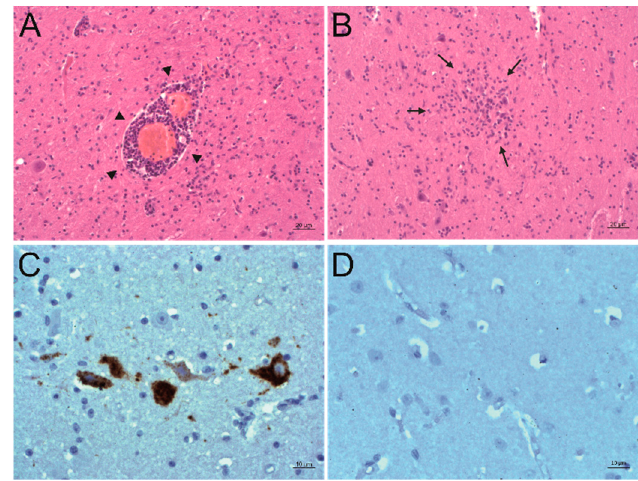
Figure 5. Correlation of BoAstV CH13 RNA to sites of inflammation. ( A , B ) Histopathological analysis. Hematoxylin and eosin (H&E) staining of the midbrain of animal 26875. Signs of non-suppurative encephalitis are present as perivascular cuffs ( A , arrowheads) and glial nodes ( B , arrows). ( C , D ) Detection of viral RNA with in situ hybridization (ISH) using the BoAstV RNAscope probe. In the midbrain of animal 26875 ( C ), BoAstV CH13 RNA (brown) can be seen in neurons, whereas in negative control animal 44285 ( D ), no BoAstV CH13 RNA can be detected. Scale bars: 20 µm ( A , B ) and 10 µm ( C , D ).